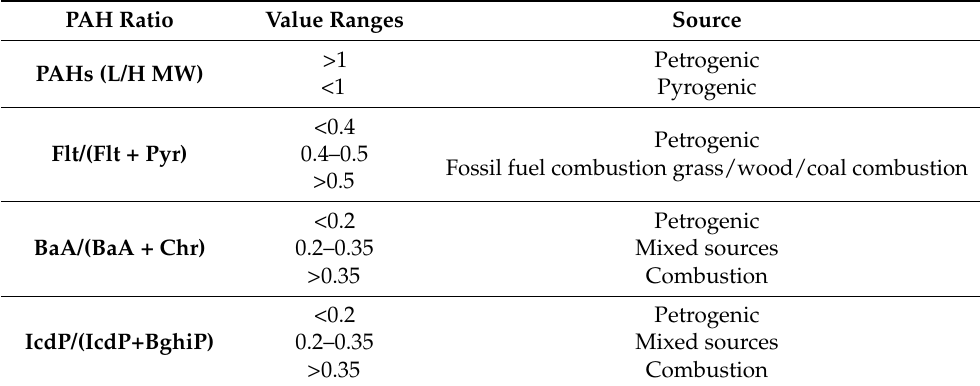
>1 <1 <0.4 0.4–0.5 Fossil fuel combustion grass/wood/coal combustion >0.5 <0.2 0.2–0.35 >0.35 <0.2 0.2–0.35 >0.35